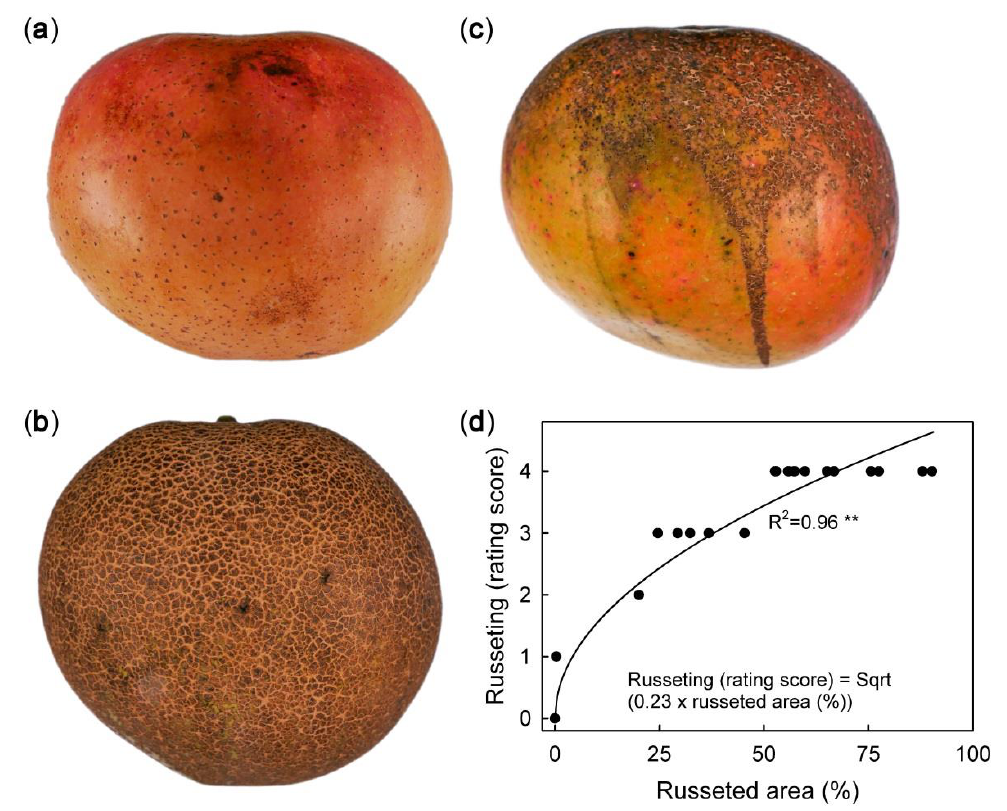
Figure 1. Macroscope view of mature ‘Apple’ mango without ( a, score 0 ), moderate ( b, score 2 ), and extreme ( c, score 4 ) russet symptoms. ( d ): Plot of russeting (rating score) against percentage area affected by russet (image analysis). Each fruit was rated visually prior to image analysis. The number of observations was 18.